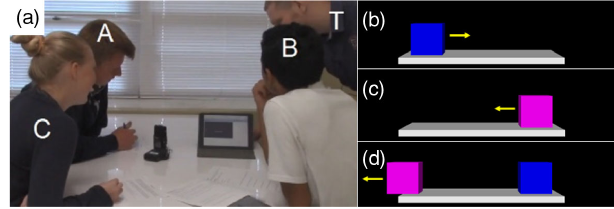
FIG. 3. (a) A group of three students (pseudonyms A, B, and C) discuss their computational model with the teacher (T). The students ’ model displays (b) first a blue box moving to the right, (c) then the blue box stopping on the right side of the platform and a pink box appearing after the blue box completes its motion, and (d) lastly the pink box continuing its motion infinitely to the left of the platform. Yellow arrows in (b), (c), and (d) have been added to illustrate the direction of motion for each crate at different